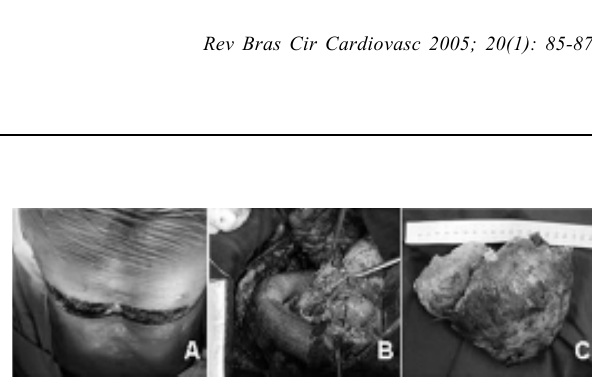
trombo intraluminal envolvido no aneurisma.